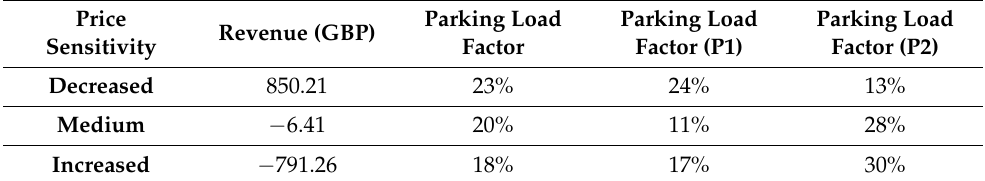
Table 3. Analysis of revenue and parking load factor sensitivity to price